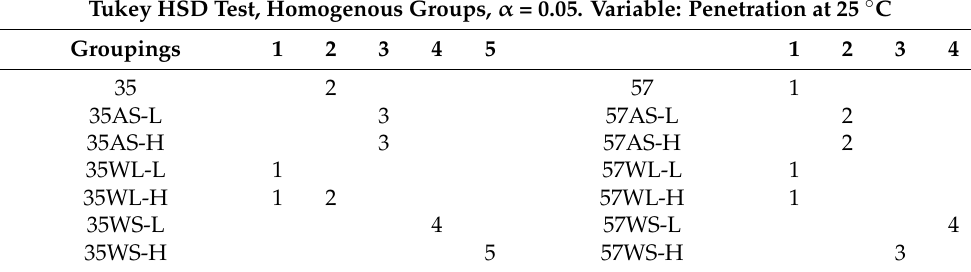
Table 3. Results of Tukey HSD tests for distinguishing homogenous groups (penetration at 25 ◦ C, α = 0.05) within the tested bituminous binders.